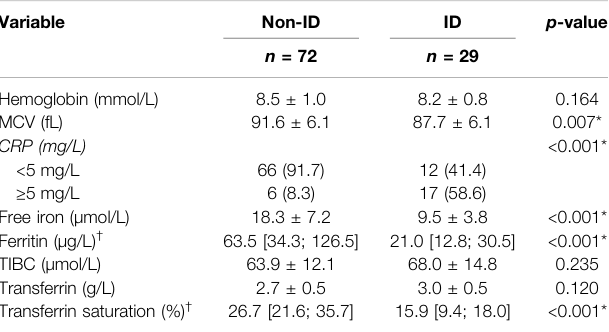
TABLE 2 | Relevant laboratory parameters of IBD patients with differences shown between IBD patients with normal iron status (non-ID) and iron de fi ciency anemia